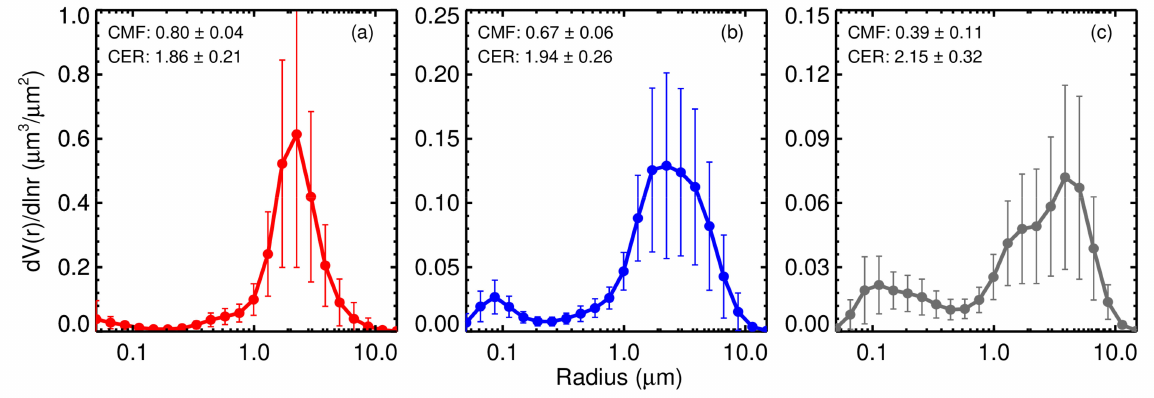
Figure 3. The average volume size distributions in Northwest China for ( a ) DD, ( b ) PD-I, and ( c ) PD-II conditions.